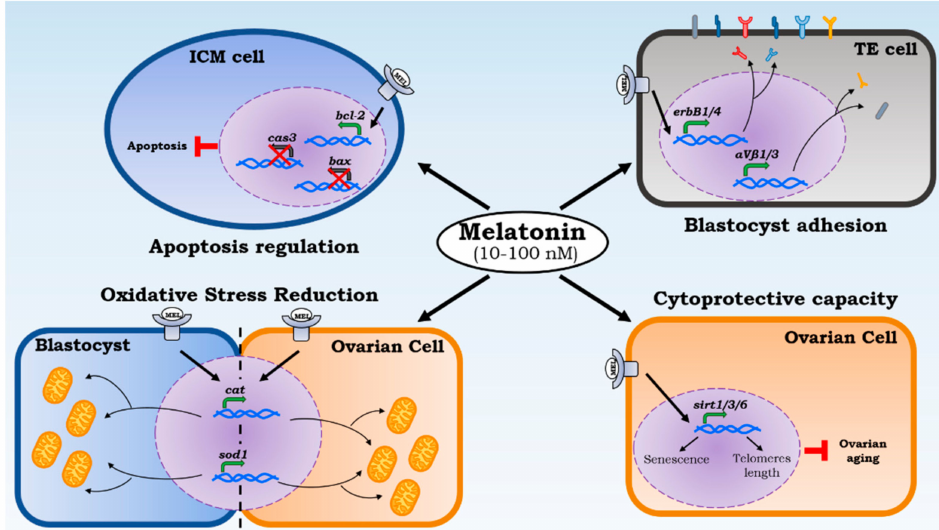
Figure 2. Melatonin local effects on implantation. Melatonin acts on different levels of implantation capacity. The cytoprotective capacity allows us to check ovarian aging by increasing sirtuins transcription (Sirt1/3/6) that protect the 3 (cid:48) end of chromosomes (telomeres) reducing the cellular senescence. ROS reduction is led by melatonin’s direct action and biosynthesis of catalase and superoxide dismutase 1. Their transcription is powered through melatonin administration in ovarian cells and blastocysts. Moreover, the apoptosis regulation and a powered adhesion proteins expression by melatonin increase the rate of blastocyst